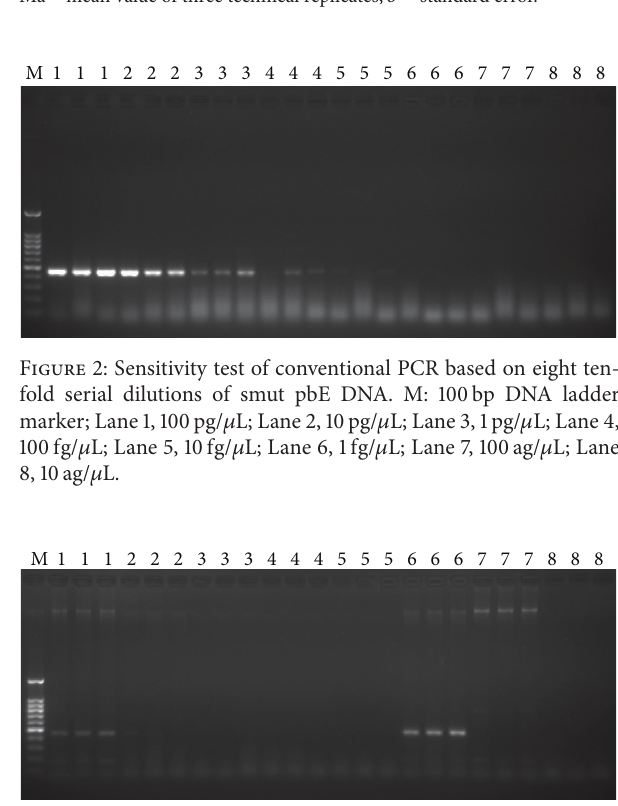
Figure 3: Sensitivity test of conventional PCR based on five-fold serialdilutionsof+1leafgDNA.M:100 bpDNAladdermarker;Lane 1, 500ng/ 𝜇 L; Lane 2, 100ng/ 𝜇 L; Lane 3, 20 ng/ 𝜇 L; Lane 4, 4 ng/ 𝜇 L; Lane 5, 0.8 ng/ 𝜇 L; Lane 6, positive control; Lane 7, mock control; Lane 8, blank